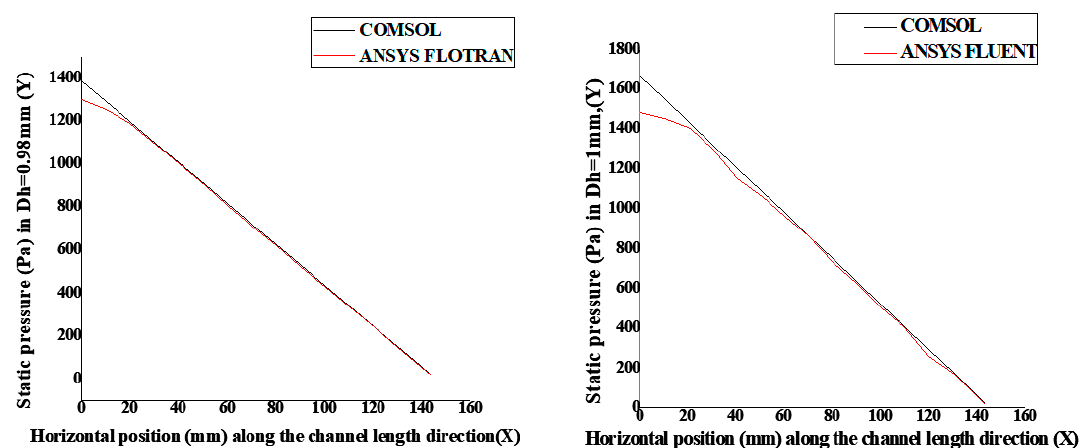
Figure 5. Drop pressure in Dh = 0.98 mm and Dh = 1 mm along with the horizontal position (mm) of the channel length.